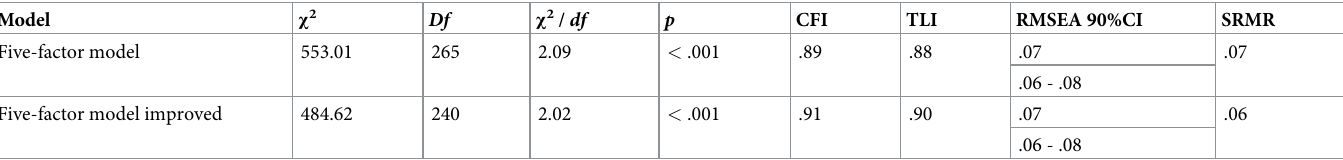
Table 1. Fit indices of the CFA models for TDEQ-5 (n =